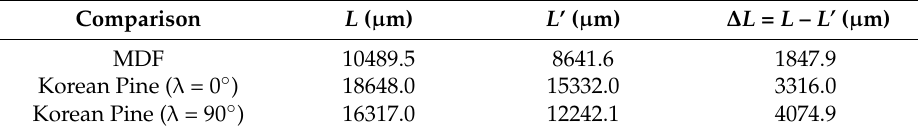
Figure 10. The accurate match of surface morphology and sanding force during a single scratch. Table 4. Comparison of the theoretical length ( L ) and measured length ( L ’) of the scratch.